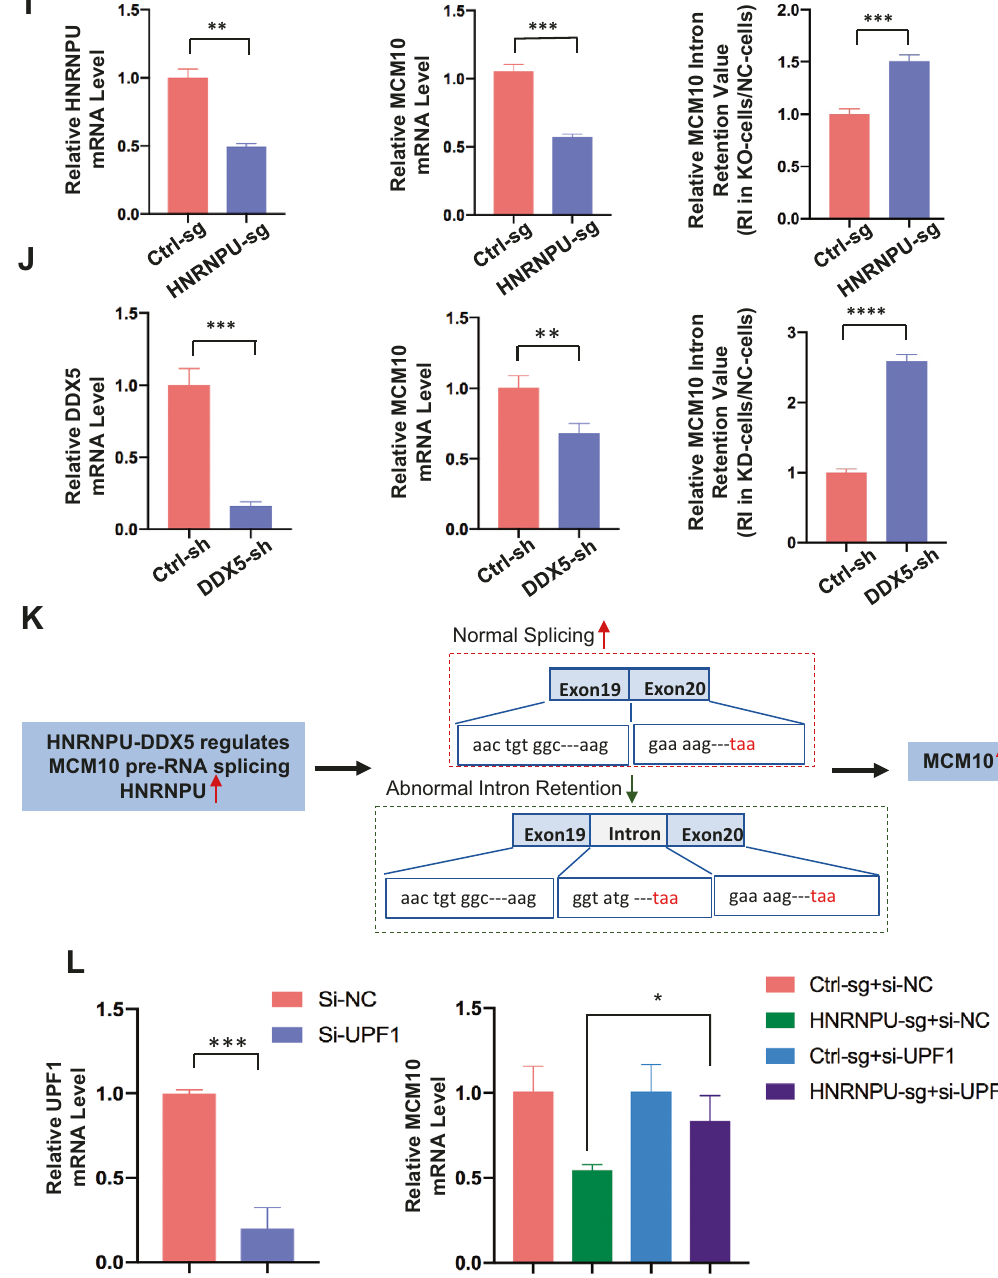
signalling pathway [38]. To gain insights into the function LMO4 exerted in breast cancer, knockdown LMO4 stable MCF10 CA1a cell lines were constructed (Fig. 6F). CCK-8 and colony formation assays revealed that the knockdown of LMO4 could signi fi cantly inhibit cell proliferation (Fig. 6G – I). Transwell migration assays showed that reduced LMO4 expression dramatically weakened the cell migration capacity (Fig. 6H, I). Moreover, Western blotting revealed that LMO4 knockdown caused a decrease in the PI3K/Akt/mTOR pathway (Fig. 6L). GSEA demonstrated that HNRNPU and DDX5 modulate the mTOR pathway transcription- ally (Figs. 5C and S4L). Western blotting con fi rmed the down- regulation of PI3K/Akt/mTOR signalling induced by HNRNPU and DDX5 (Figs. 6M and